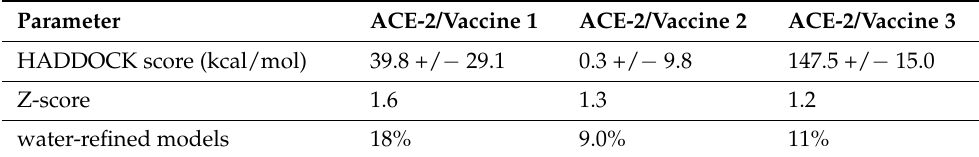
Figure 12. The docking interaction of the human ACE-2 protein complex (red) with the proposed multi-epitopic COVID-19 vaccines ( 1 – 3 ) representing in subfigures ( A – C ) (blue) respectively [122]. Permission and copyright © from www.frontiersin.org (accessed on 20 October 2021). Table 2. Static interaction parameters of ACE-2 with vaccines 1, 2, and 3.